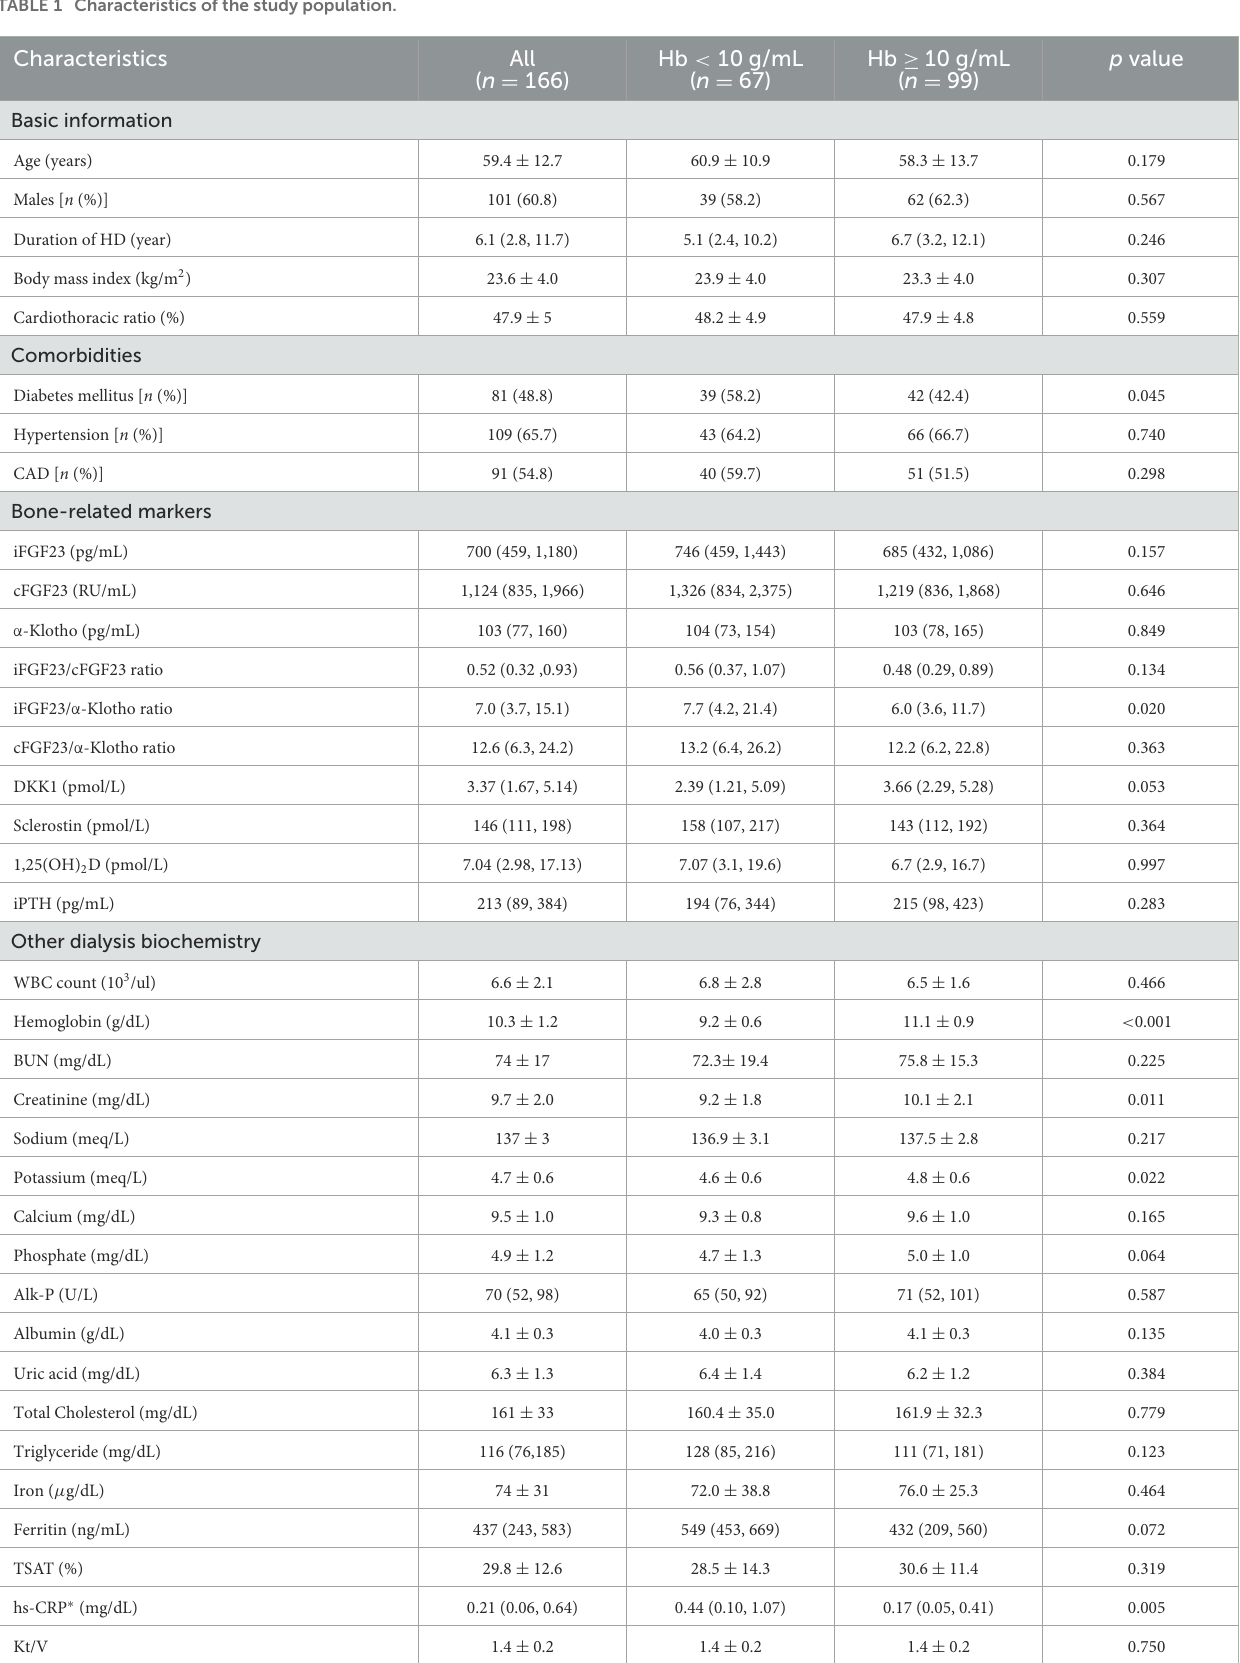
TABLE 1 Characteristics of the study